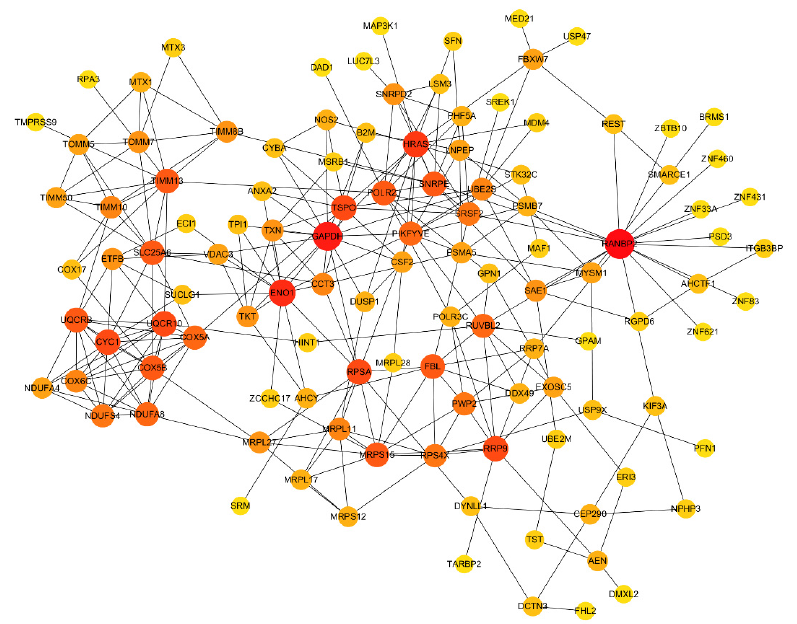
Figure 5. Protein-protein interaction (PPI) network analysis of DEGs in Tas-exo vs NC groups. PPI network constructed using selected DEGs from database. Node size and color shade represent number of interacting genes; node represents genes.